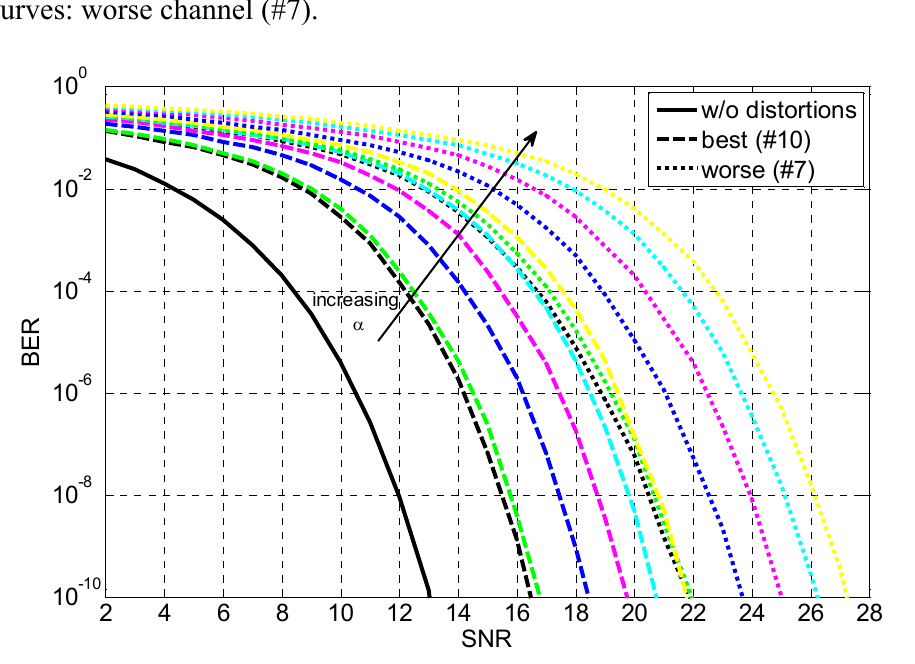
Figure 9. BER vs. SNR for transmission at 10 Gb/s of 32 NRZ-OOK channels with increasing roundtrip losses α = 0, 0.2, 0.4, 0.6, 0.8, 1. Dashes curves: best channel (#10); dotted curves: worse channel